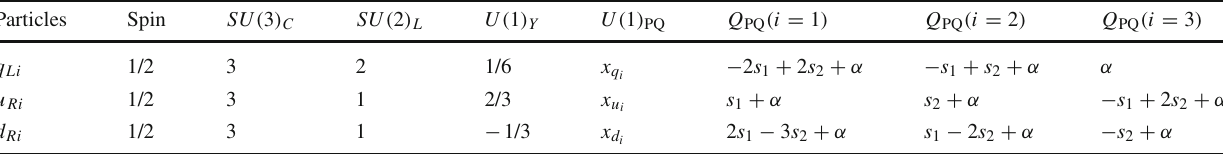
Table 1 The columns 6-8 are the PQ ( Q PQ ) charges for the SM quarks in each family. The subindex i = 1 , 2 , 3 stands for the family number in the interaction basis. The parameters s 1 , s 2 and α are reals, with s 1 (cid:9)= s 2 Particles